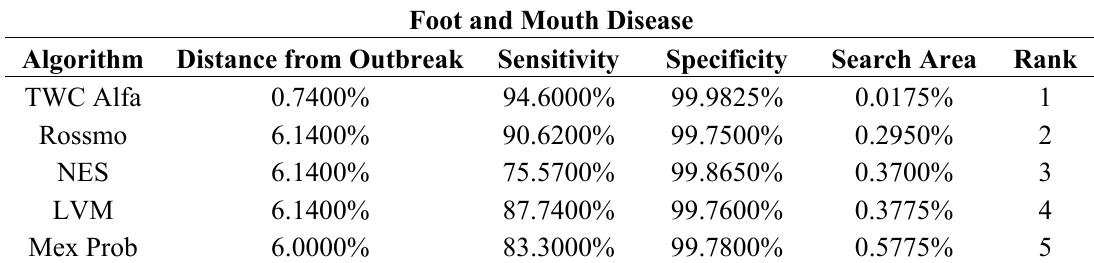
Table 1. Foot and Mouth Disease results.